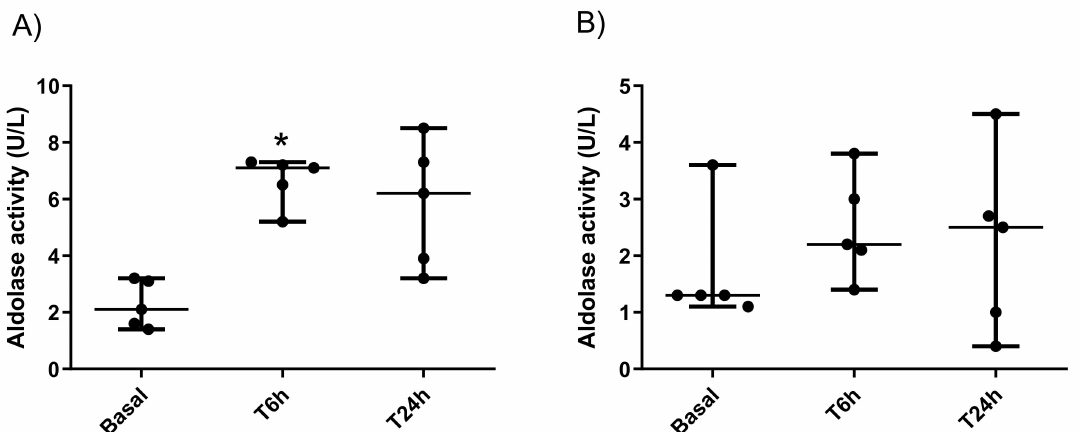
Figure 5. Salivary aldolase activity levels (U/L) during experimentally-induced sepsis in a model of LPS-challenged pigs ( A ) and non-septic inflammation in a model of turpentine-challenged pigs ( B ). Basal: 24 h before LPS- or turpentine-injection; T6 h: 6 h after LPS- or turpentine-injection; T24 h: 24 h after LPS- or turpentine-injection. Lines indicate the minimum, median, and maximum values. Asterisks indicate statistically significant differences (* p < 0.05) with basal time. Circles represent the sample values.